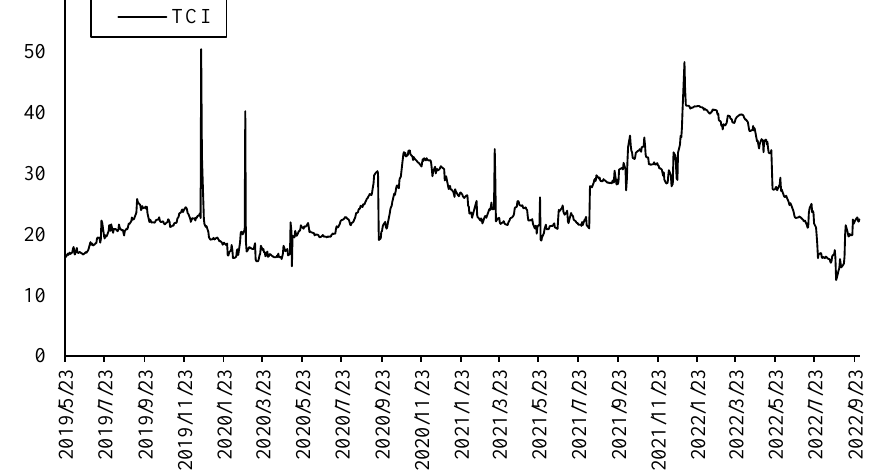
Figure 5. TCI of the first layer (five electricity markets).